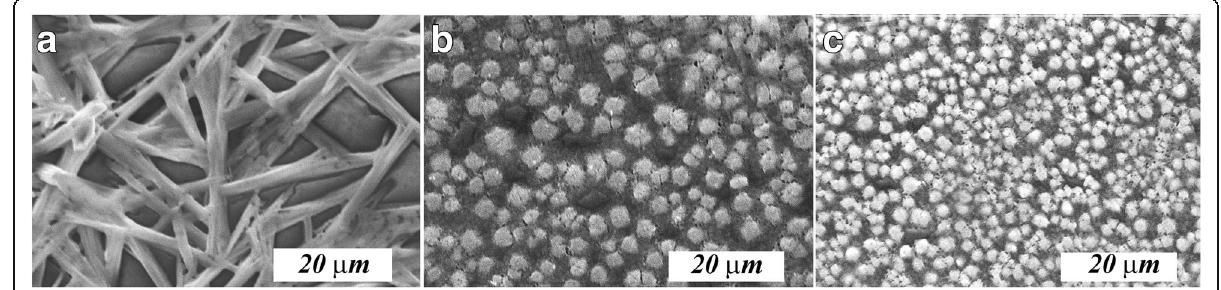
Fig. 4 Microstructure of films CH 3 NH 3 PbI 2.98 Cl 0.02 after heat treatment at 80 ° С and the ratio of starting reagents (PbI 2 and CH 3 NH 3 І ) 1:1 ( a ), 1:2 ( b ), and 1:3 ( c )